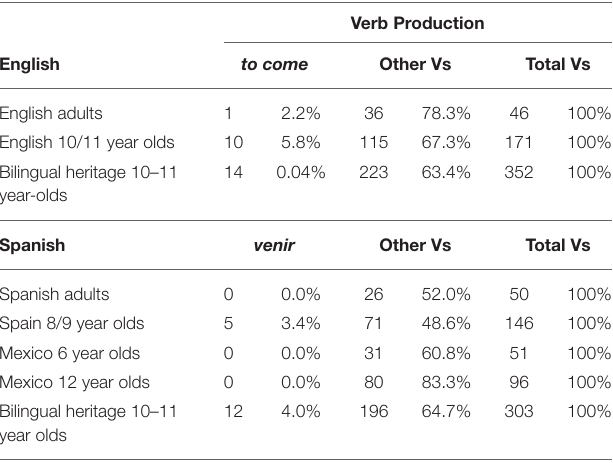
TABLE 2 | Raw count and percentage of productions of “to go” (in Spanish, ir ) TABLE 1 | Raw count and percentage of productions of “to come” (as come or venir ) in six scenes and overall, compared to other verbs. relative to all verbs in the “bee” Verb Production English to come